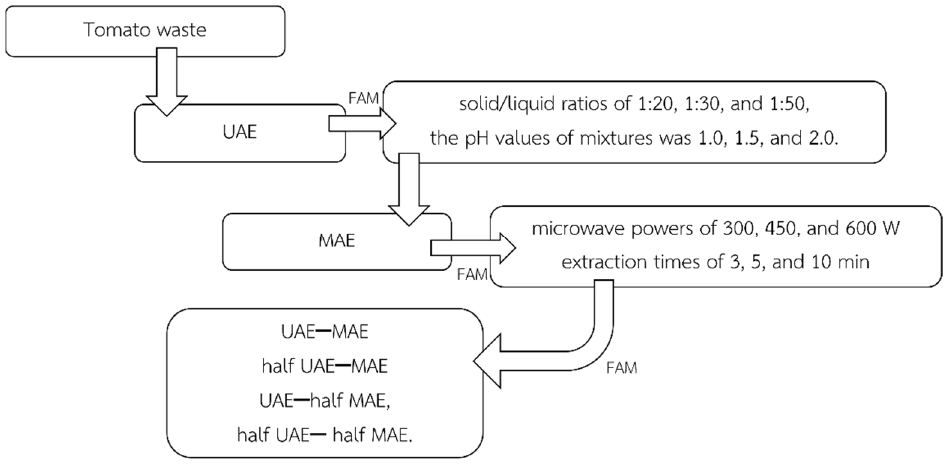
Figure 3. The schematic diagram of pectin extraction in this